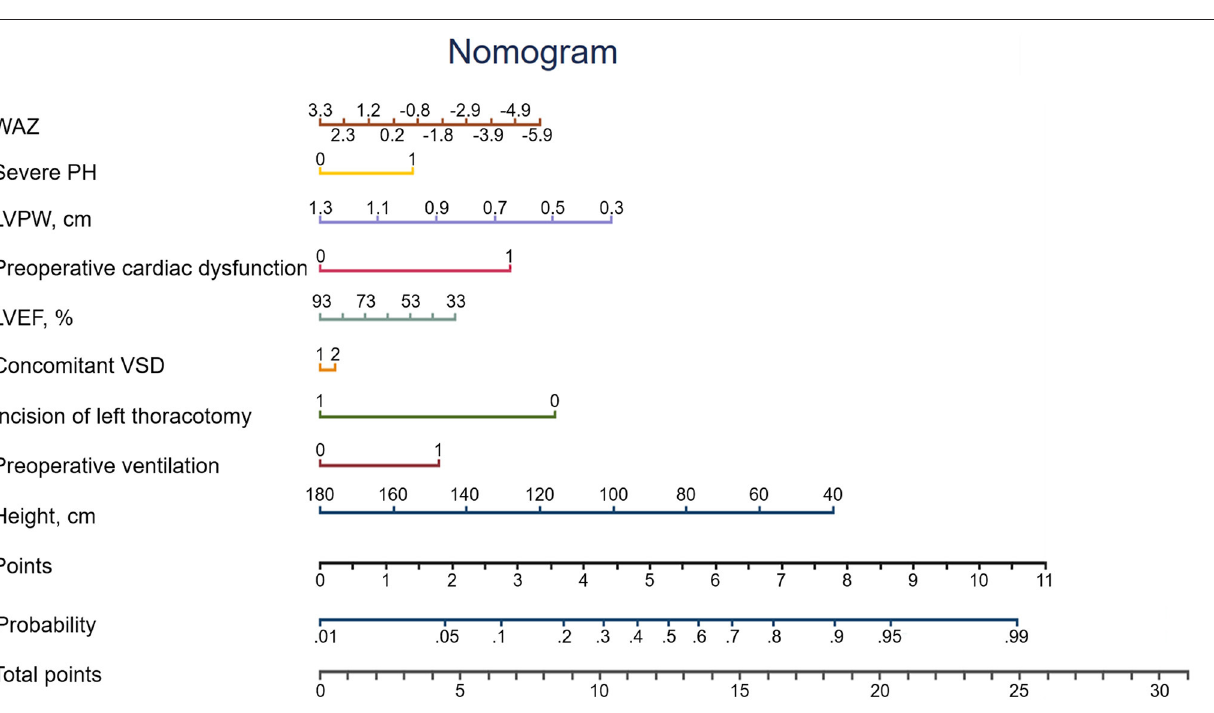
The Lasso model was superior to both of the ABC score and the RACHS-1 category when these models were applied to the overall population (AUC = 0.8131, 0.7046, and 0.6895, respectively; p < 0.001) ( Figure 3D ). Moreover, remarkable improvements in reclassification and discrimination was achieved in the overall population, comparing the Lasso model with the ABC score (NRI = 70.8%, IDI = 13.0%) and with the RACHS-1(NRI = 74.4%, IDI =